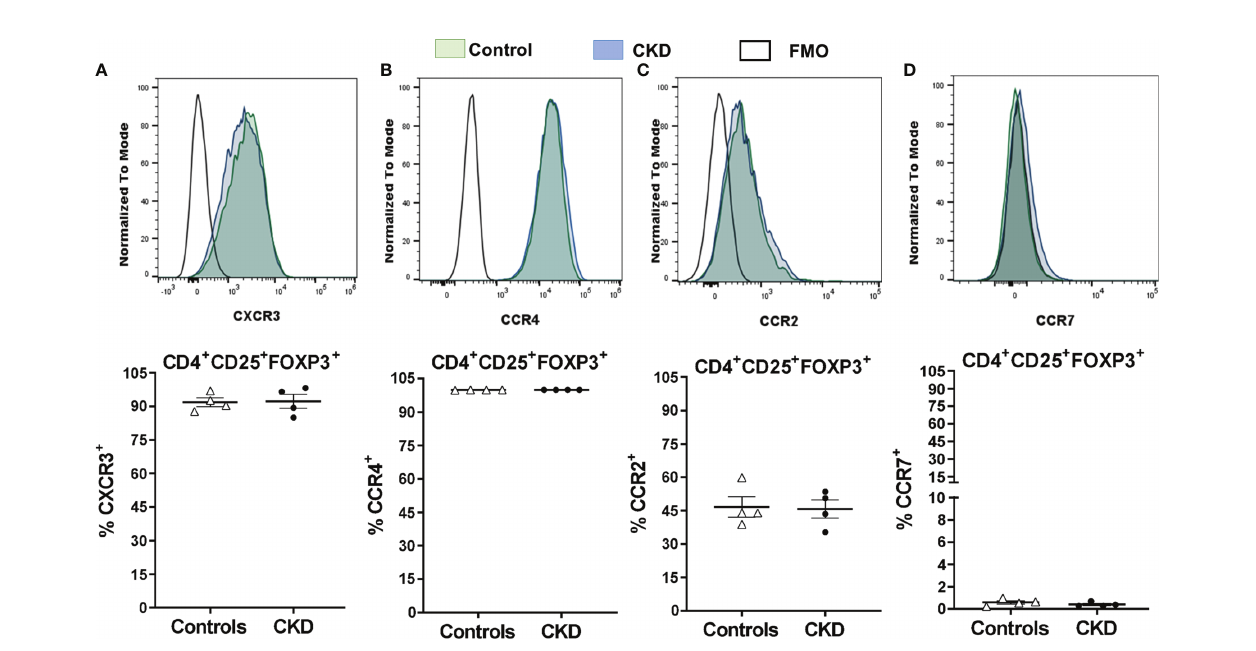
FIGURE 9 | Cryopreserved allospeci fi c regulatory T cells ( allo Tregs) expressed high levels of the chemokine receptors CXCR3, CCR4, and CCR2. Long-term cryopreserved allo Tregs from healthy controls ( white triangles , n = 4) or patients with chronic kidney disease (CKD) ( black circles , n = 4) were thawed and polyclonally expanded for 2 weeks. The expressions of chemokine receptors were determined by fl ow cytometry. (A, B) The expanded Tregs of both groups had high percentages of CXCR3 + (A) , CCR4 + (B) , and CCR2 + (C) cells, but a low proportion of CCR7 + cells (D) . Representative experiments are shown in (A – D) . White histograms represent FMO ( fl uorescence minus one) controls. The results are shown as the mean ± SEM. Statistical analysis was performed using unpaired t -test. No signi fi cant differences were